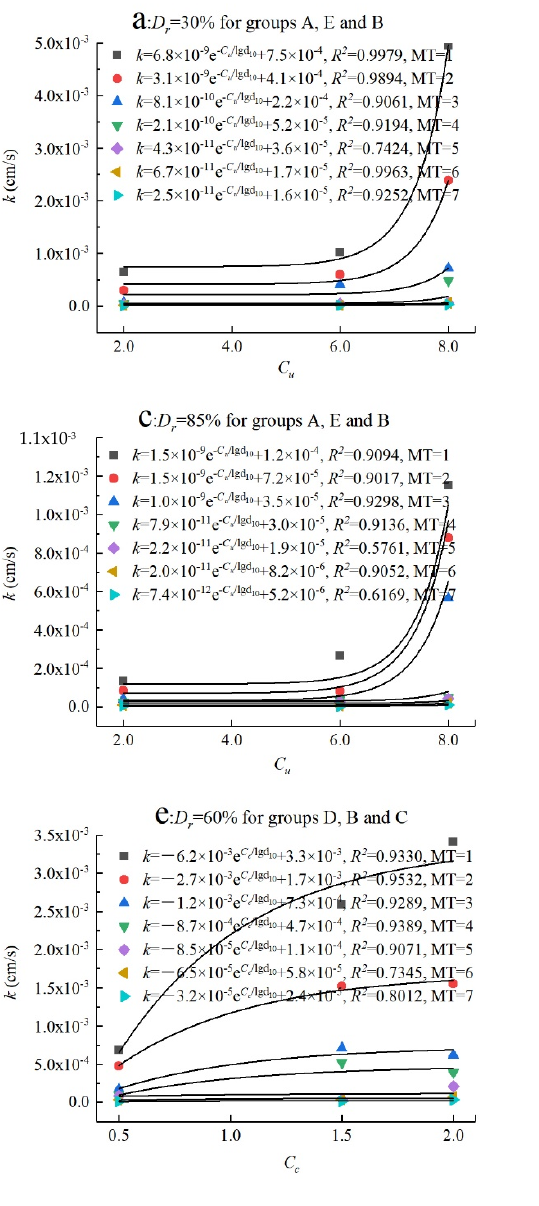
Figure 11. Correlation of permeability coefficient (k) with uniformity coefficients (Cu) and curvature coefficient (Cc), respectively, for sand samples with a varied number of MICP treatments (MT) and relative densities ( D r ): in Figure ( a – c ), Cu =2.0, 6.0 and 8.0 for samples A, E and B, respectively; in Figure ( d – f ), Cc =0.5, 1.5 and 2.0 for samples D, B and C, respectively.